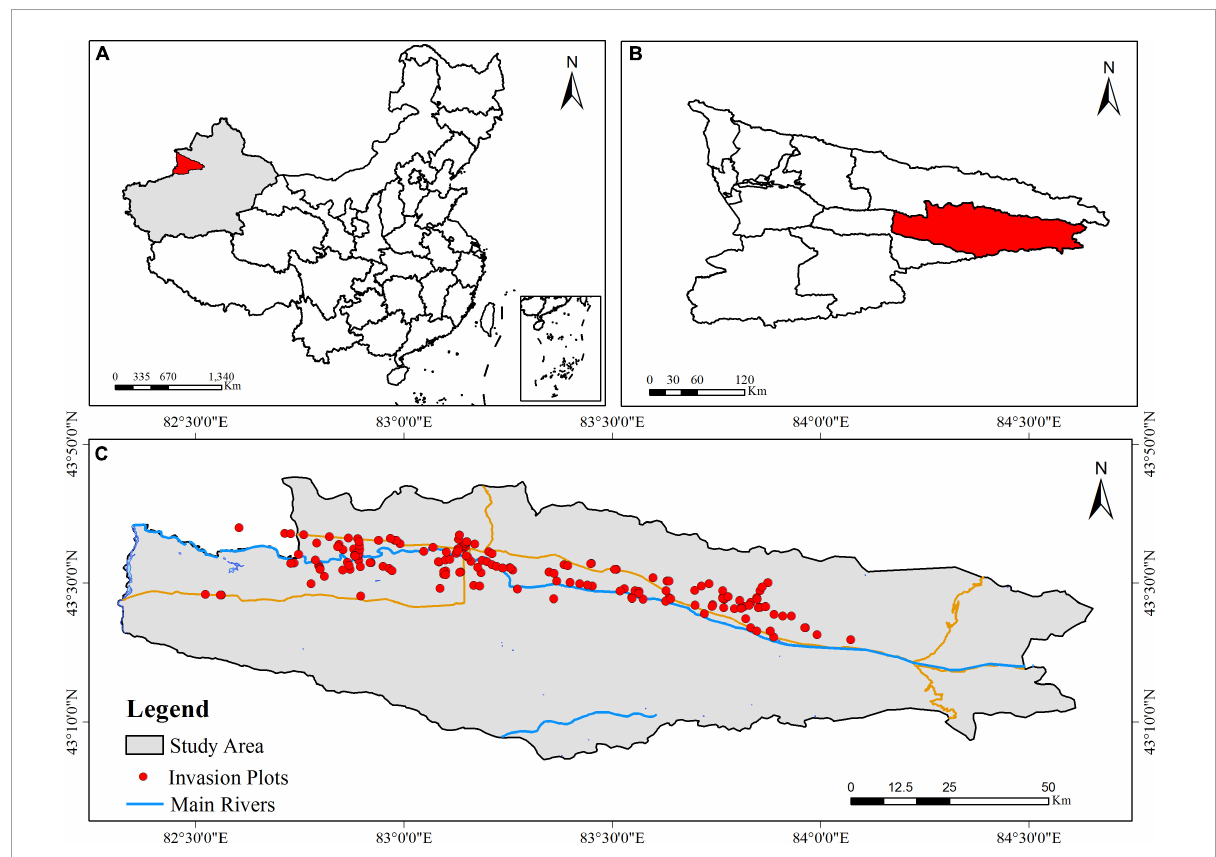
FIGURE1 Distribution points of Ambrosia artemisiifolia invasion communities in the study area. (A) The semi-arid regions Xinjiang is located in northwest of China. (B) The Yili Valley is located in northwest of Xinjiang. (C) Study area in the Yili